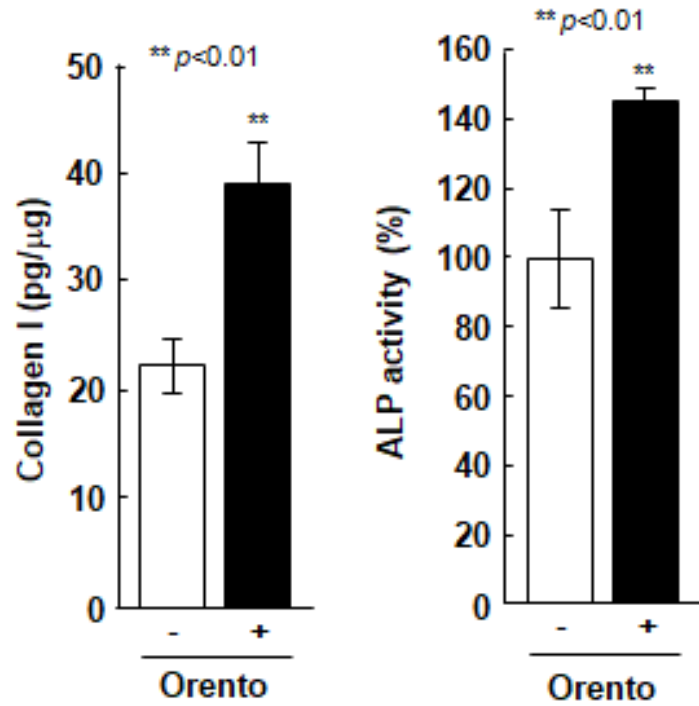
Figure 3. Collagen type 1 production in Saos-2 cells treated with orento and ALP secretion in Saos-2 cells treated with orento. ** is p < 0.01.